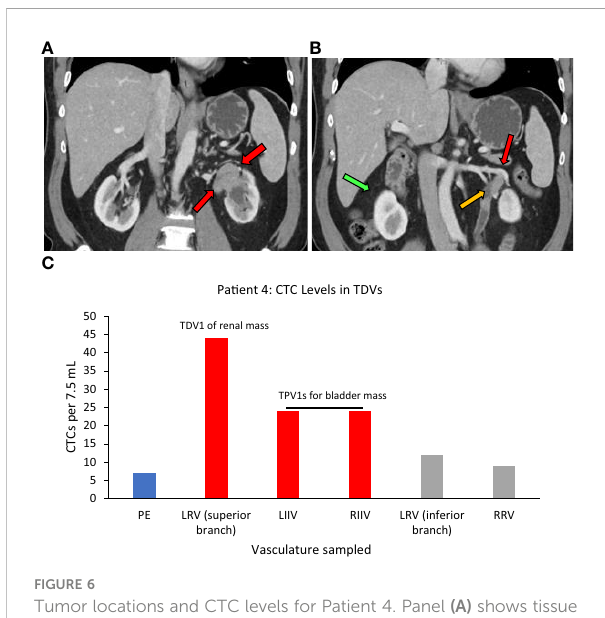
FIGURE 6 Tumor locations and CTC levels for Patient 4. Panel (A) shows tissue biopsy-proven synchronous renal pelvic urothelial carcinoma on the left side (red arrows point to the tumor). Red and yellow arrows in (B) point to the superior branch of the left renal vein (LRV) (designated TDV1) and inferior branch of the LRV (not tumor- draining, similar to peripheral vein (PE)) for the renal mass, respectively, and the green arrow points to the right renal vein (RRV). Panel (C) shows CTC levels in the tumor-draining and peripheral veins of this patient with the highest levels seen in TDV1 for the renal mass and the left and right internal iliac veins (LIIV and RIIV) which are the TPV1s for the bladder mass. PE – peripheral vein. TDV1s are in red, TPVs in grey, and PE in blue.